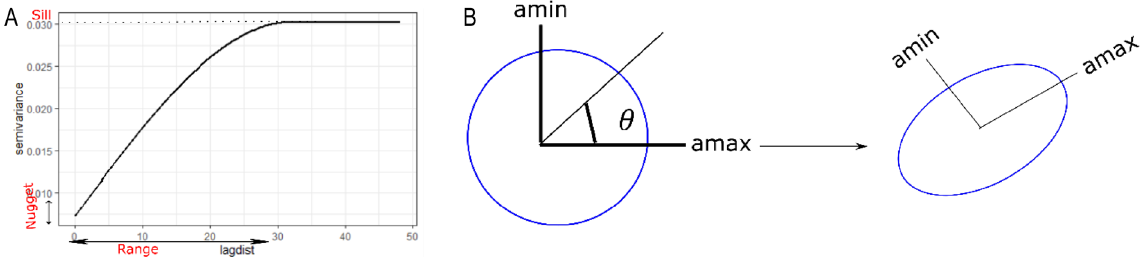
Figure 1. ( A ) Variogram plot derived from spatial data. A variogram shows the amount of spatial autocorrelation in the data where the parameter ‘Range’ indicates the distance between two observations beyond which observations appear independent. The ‘sill’ is the point at which semi -variance reaches an asymptote. The nugget is the spatial variability at the origin. The variogram plot is created using R-package gstat 62 . ( B ) The conversion of isotropic spatial coordinates to anisotropic spatial coordinates. The isotropic spatial data has the same amount of spatial autocorrelation in all directions while in anisotropic data particular direction has stronger autocorrelation than other directions. Isotropic data can be converted into anisotropic data using rotation and scaling matrix (see “Material and